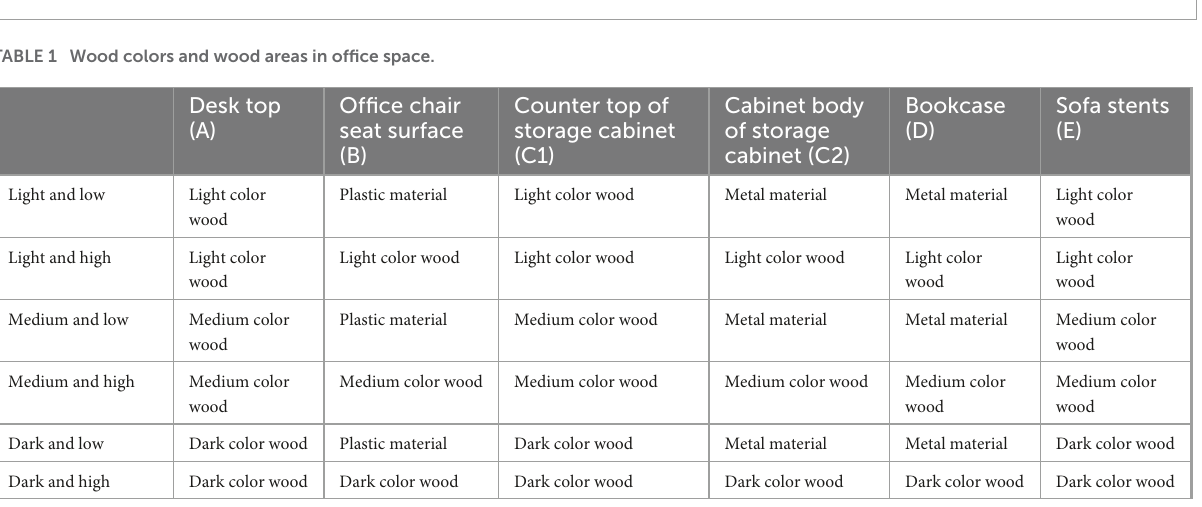
FIGURE1 Wooden office space wood application location diagram. Reproduced with permission from https://www.6mo.cn.